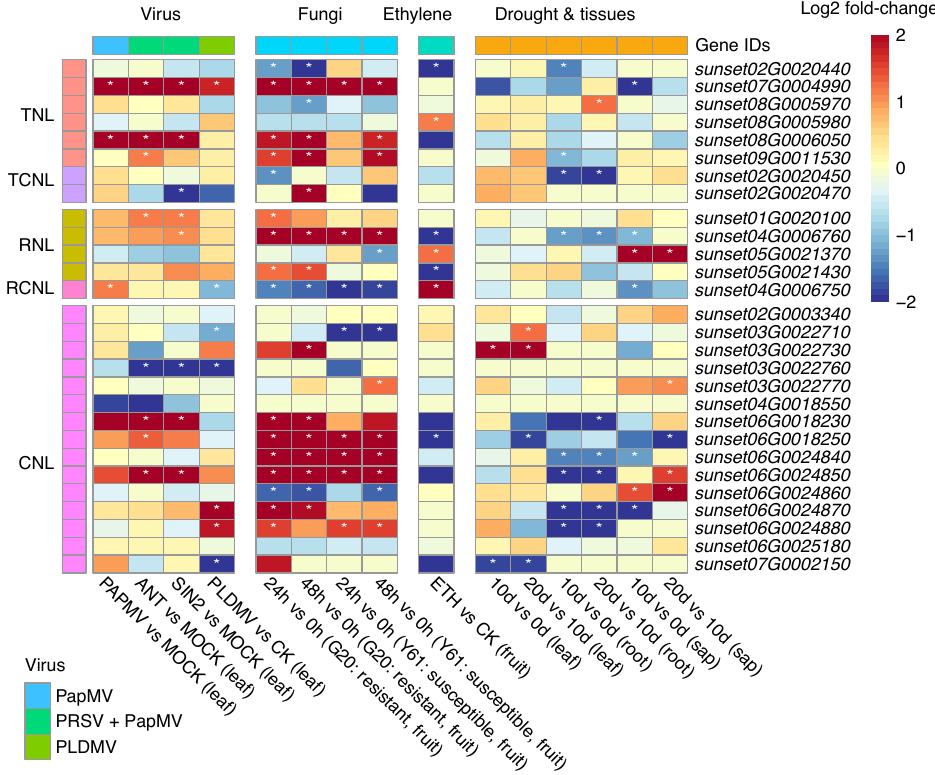
Figure 7. Log2 fold-change expression of NLRs in papaya under biotic and abiotic stresses. DEGs are marked by white starts with Log2 fold-change > 1 and P FDR < 0.05. ANT indicates ‘Antagonism’ samples, which are inoculated with simultaneous PapMV and PRSV [47]. SIN2 indicates ‘Sinergism2’ samples, which are inoculated with stepwise PapMV and PRSV